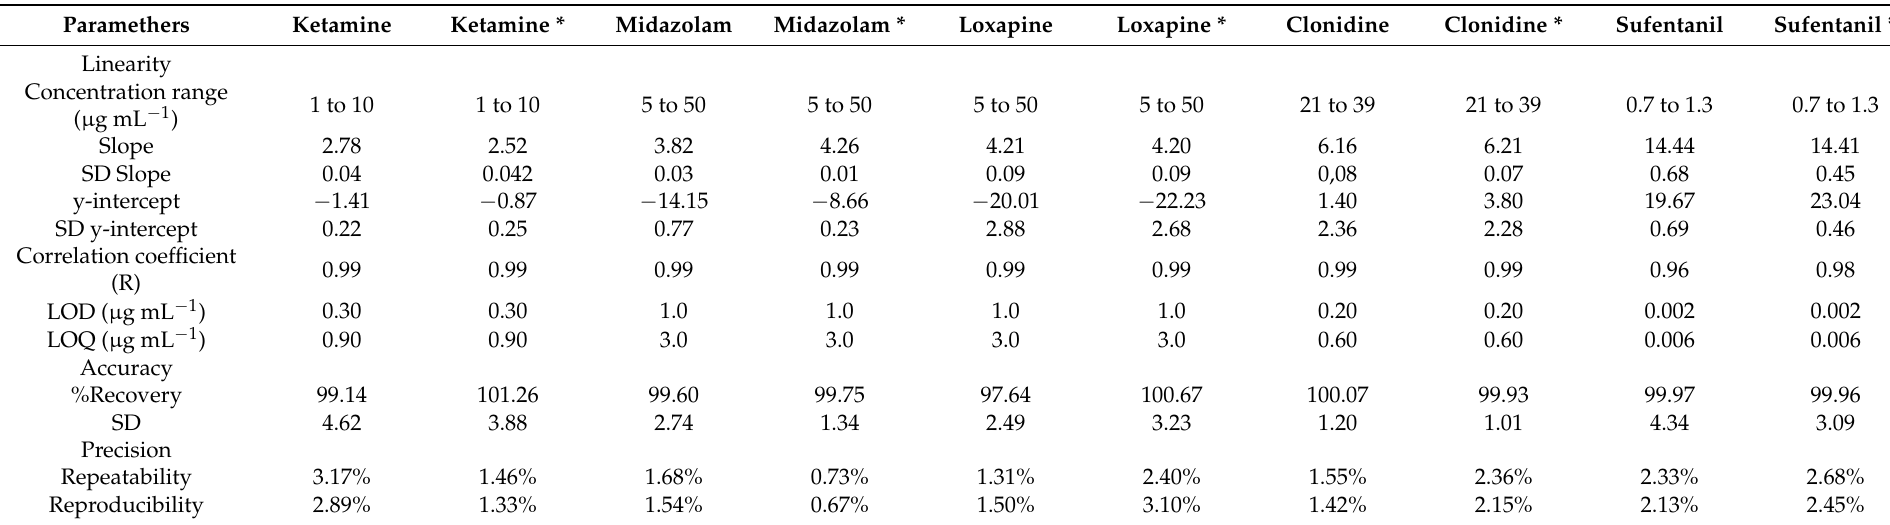
Table 4. LC method validation